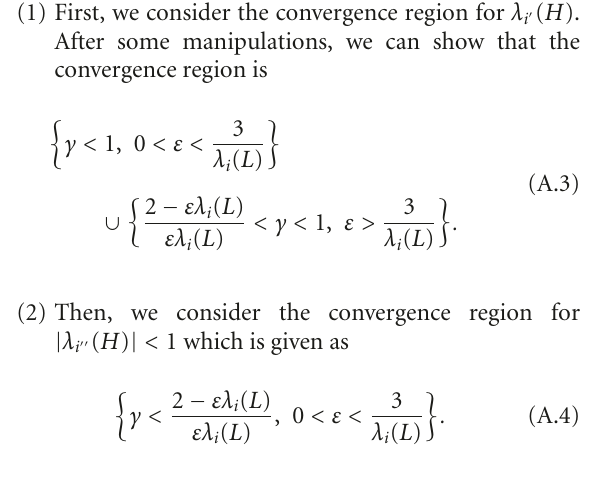
Figure 9: Evolution of the average disagreement of the SO-DCTS algorithm in random network (see Figure 7) with Gaussian delay between network